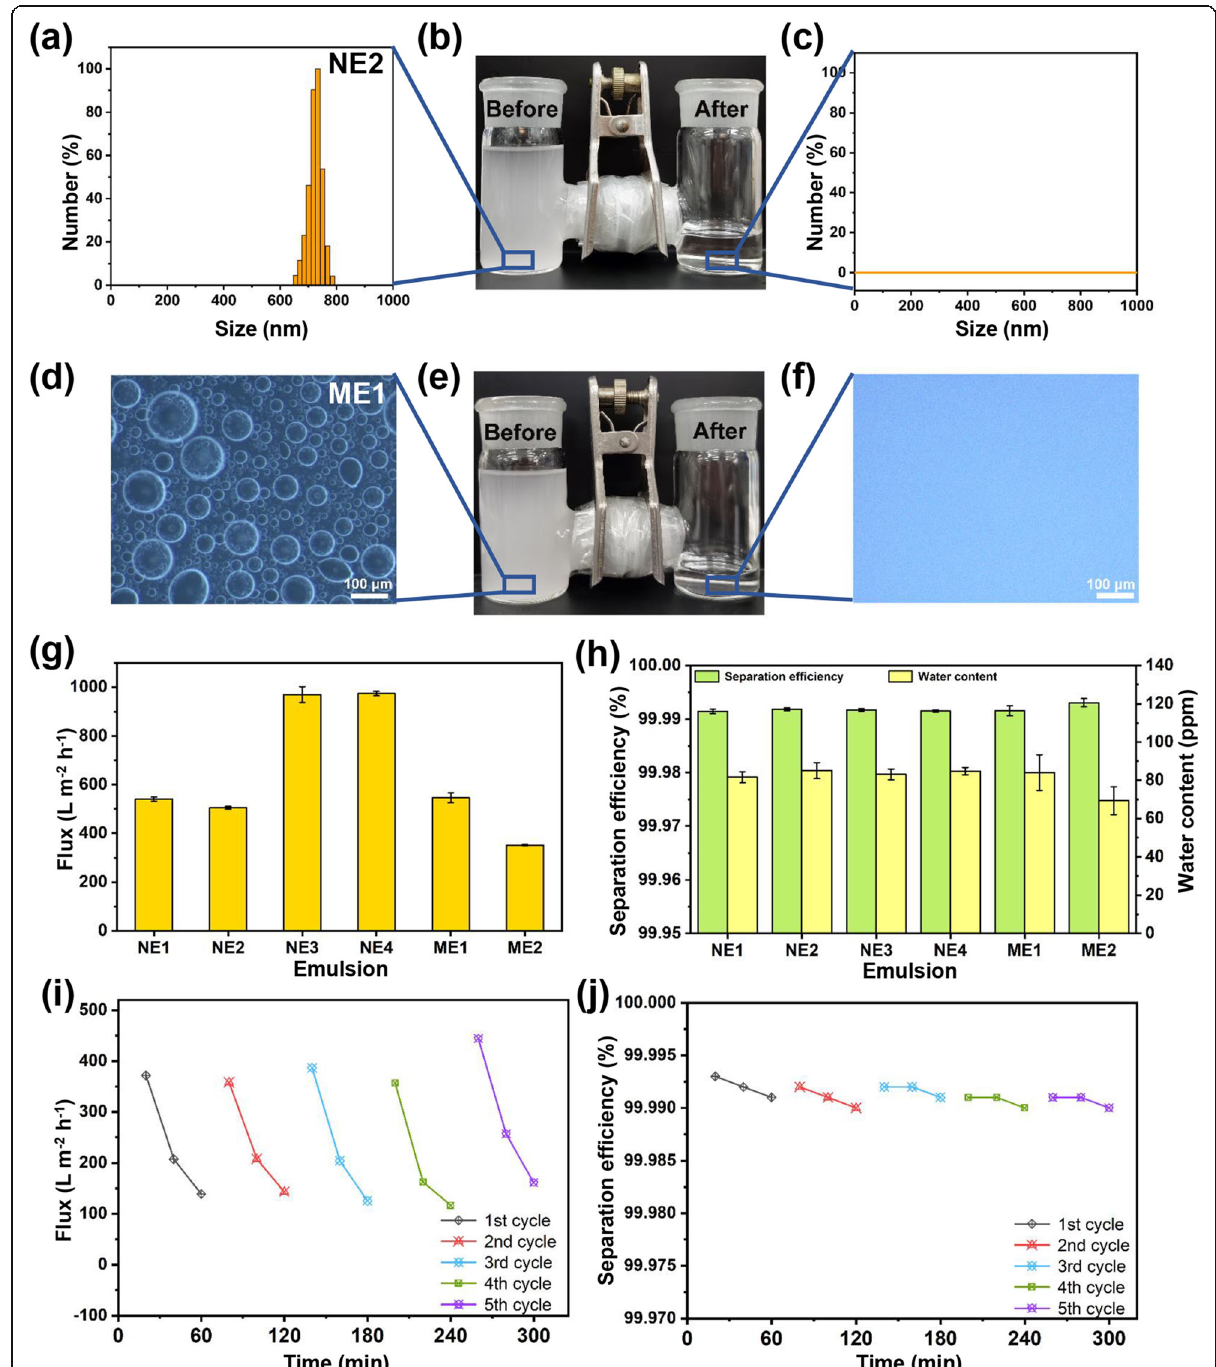
Fig. 3 DLS curves of NE2 before ( a ) and after ( c ) the filtration through the double-layer CFM/UiO-66(12)/PDMS membranes, digital photograph of the H-shaped separation device for NE2 separation ( b ), optical microscopy images of ME1 before ( d ) and after ( f ) the filtration through the double-layer CFM/UiO-66(12)/PDMS membranes, digital photograph of the H-shaped separation device for ME1 separation ( e ), separation fluxes of the double-layer CFM/UiO-66(12)/PDMS membranes to NE1, NE2, NE3, NE4, ME1 and ME2 ( g ) and the corresponding water contents in the filtrate and separation efficiencies ( h ), separation fluxes of NE2 obtained during the 5 cycles of separation by using the double-layer CFM/UiO- 66(12)/PDMS membranes ( i ), separation efficiencies of NE2 obtained during the 5 cycles of separation by using the double-layer CFM/UiO-66(12)/ PDMS membranes ( j